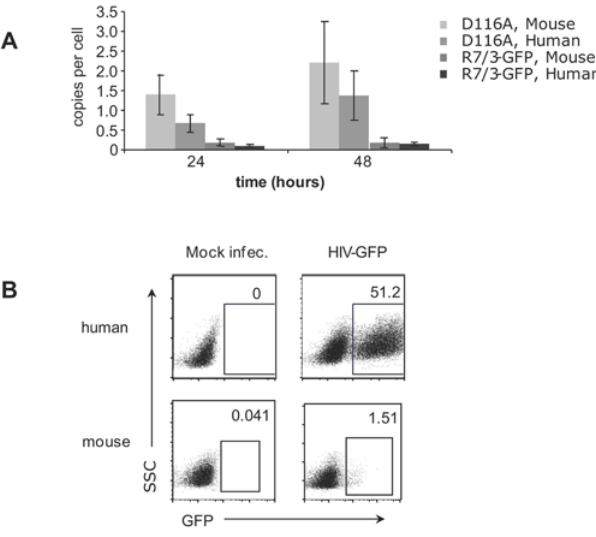
Figure 3. Primary CD4 + T cells from hCyclin T1 mice support efficient nuclear import of HIV-1 but less efficient integration. (A) CD4 + T cells from hCyclin T1 transgenic mice and human donors were activated and infected with VSVG-pseudotyped R7/3-GFP at MOI of 0.3 or its D116A integrase mutant virus with similar amount of RT as described in Materials and Methods. At 24 and 48 h post infection, cells were collected and subjected to real-time PCR specific for 2LTR circles. (B) CD4 + T cells from hCyclin T1 transgenic mice were activated and infected with VSVG-pseudotyped HIV-GFP at MOI of 2 as described in Materials and Methods. Cells were removed from anti-CD3/28 antibody at 3 h post infection. Infection was assessed by GFP expression using flow cytometry at 48 h post-infection. For comparison, activated human CD4 + T cells were infected and analyzed in parallel. All data represented three independent